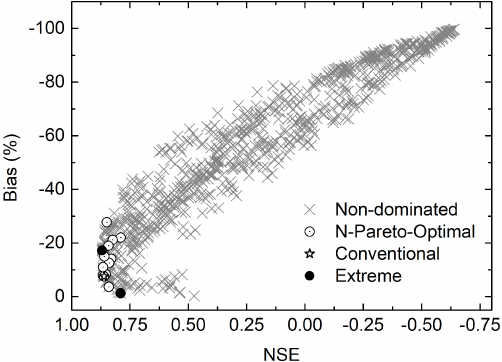
Figure 2. Two-dimensional Pareto plots for bias and NSE at Nuge- sha. The crosses indicate all the non-dominated solutions, and the circle ones are selected N -Pareto-optimal parameter sets. The con- ventional parameter set is denoted as